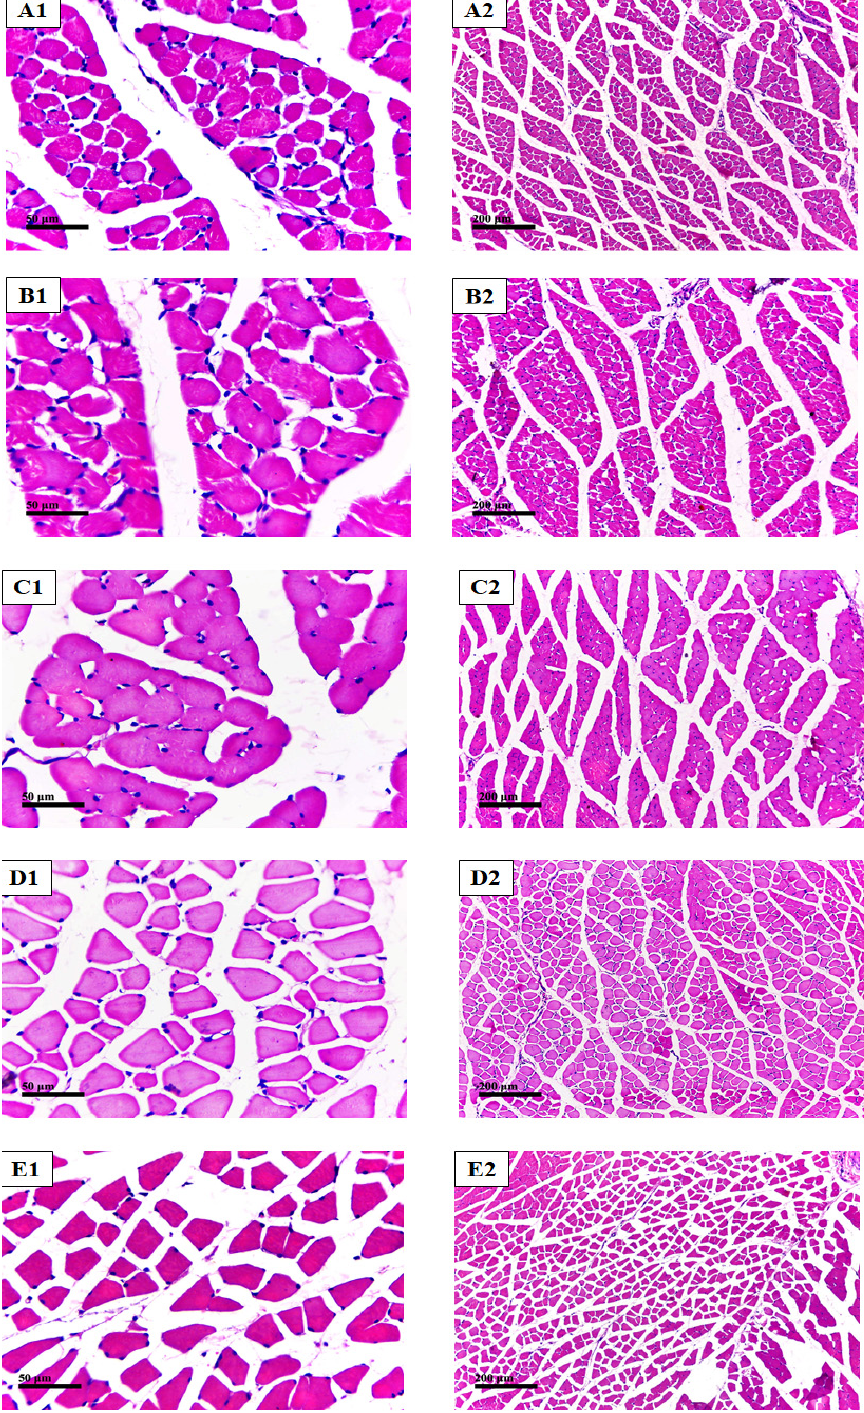
Figure 13. ( A1 , A2 ): sections from the negative control. ( B1 , B2 ), ( C1 , C2 ), ( D1 , D2 ), ( E1 , E2 ): sections from groups receiving methandienone, testosterone, 20-HE and TEAD, respectively.